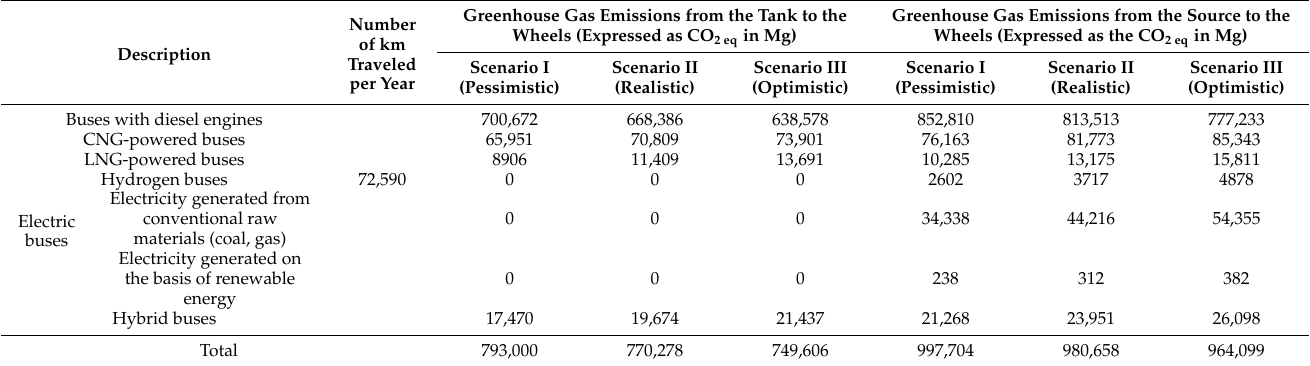
Table 6. CO 2 emissions for scenarios